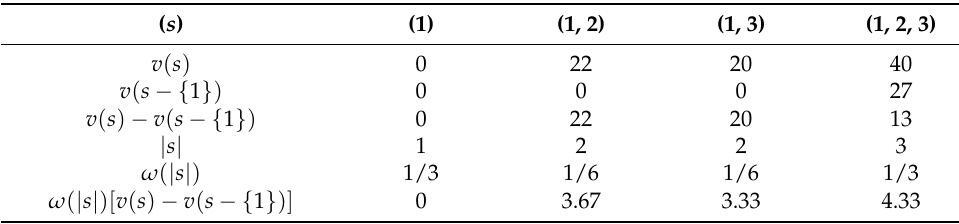
Table 1. Profit distribution table of enterprise 1.